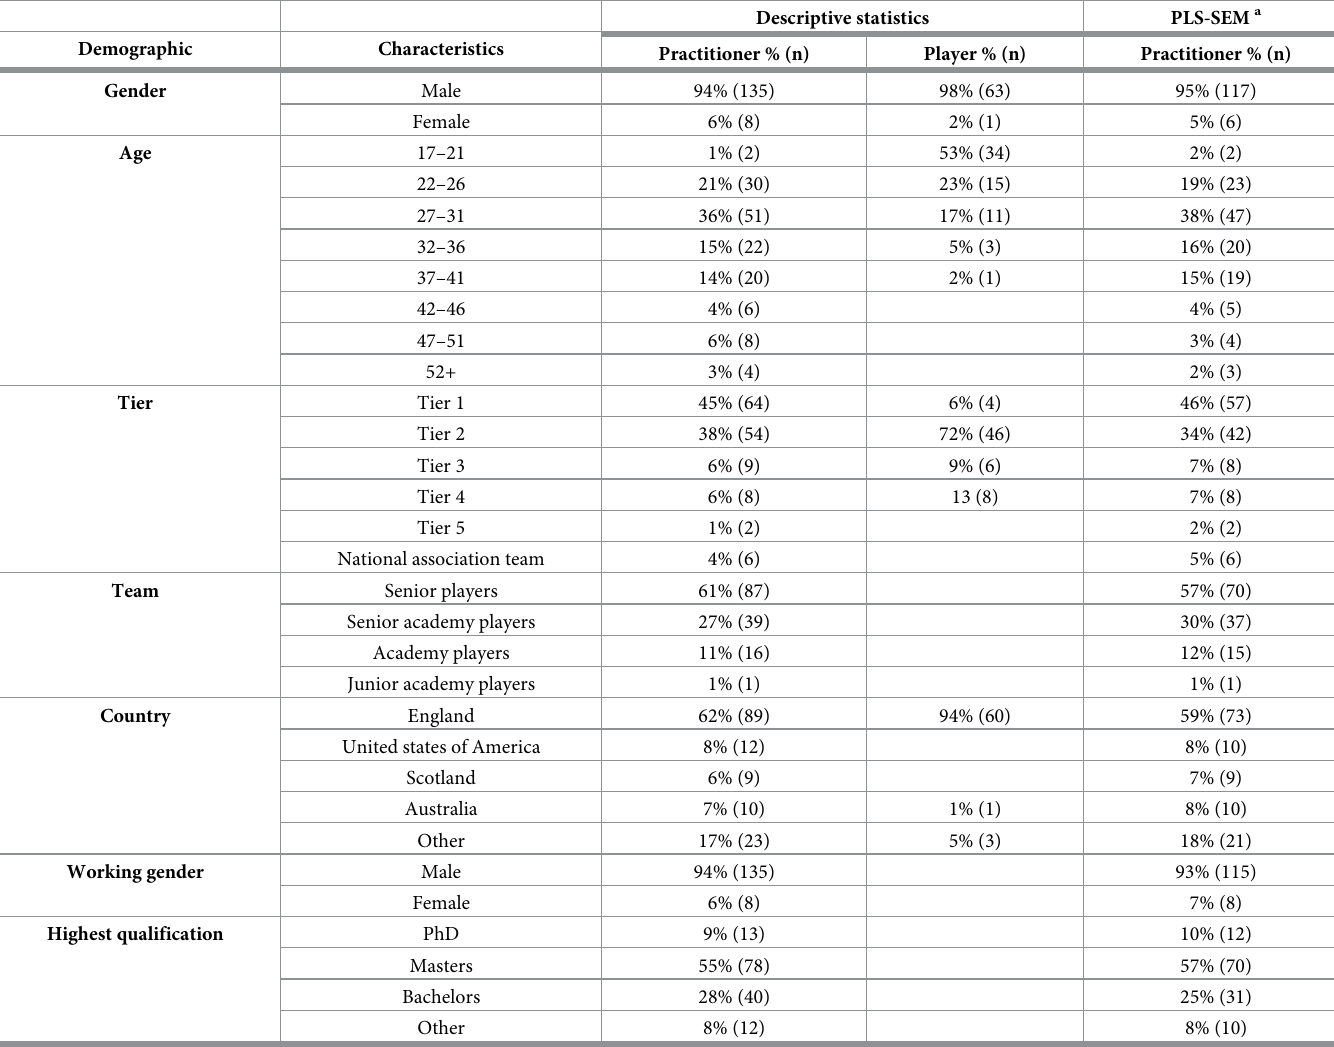
Table 2. Proportion and frequency of respondent demographics for practitioners and